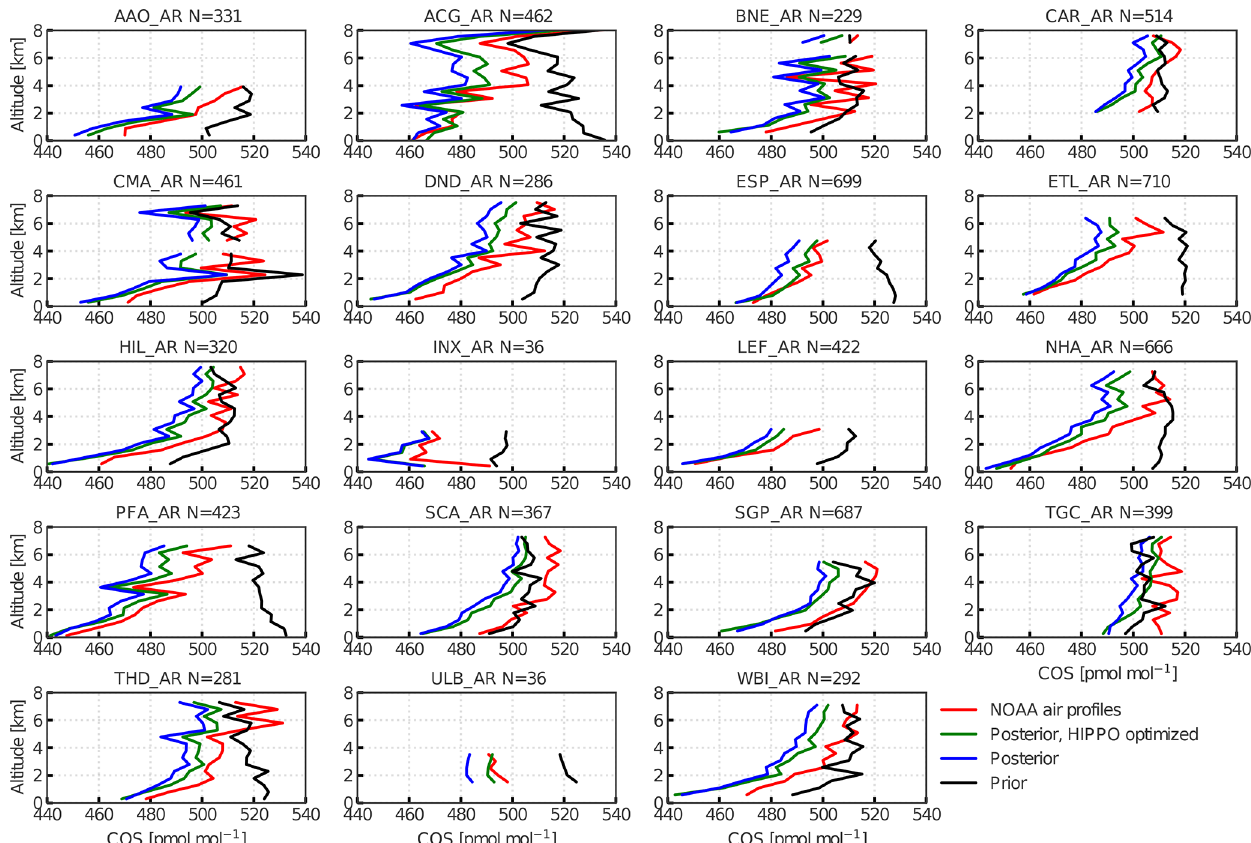
Figure 9. Prior (black) and posterior (blue) profiles of inversion S1, compared to NOAA aircraft profiles (red). Location (see Fig. 1) and number of observations are mentioned in the caption. The green lines are results from an inversion into which, besides NOAA surface observations, HIPPO observations are also assimilated. Note that the profiles are from all